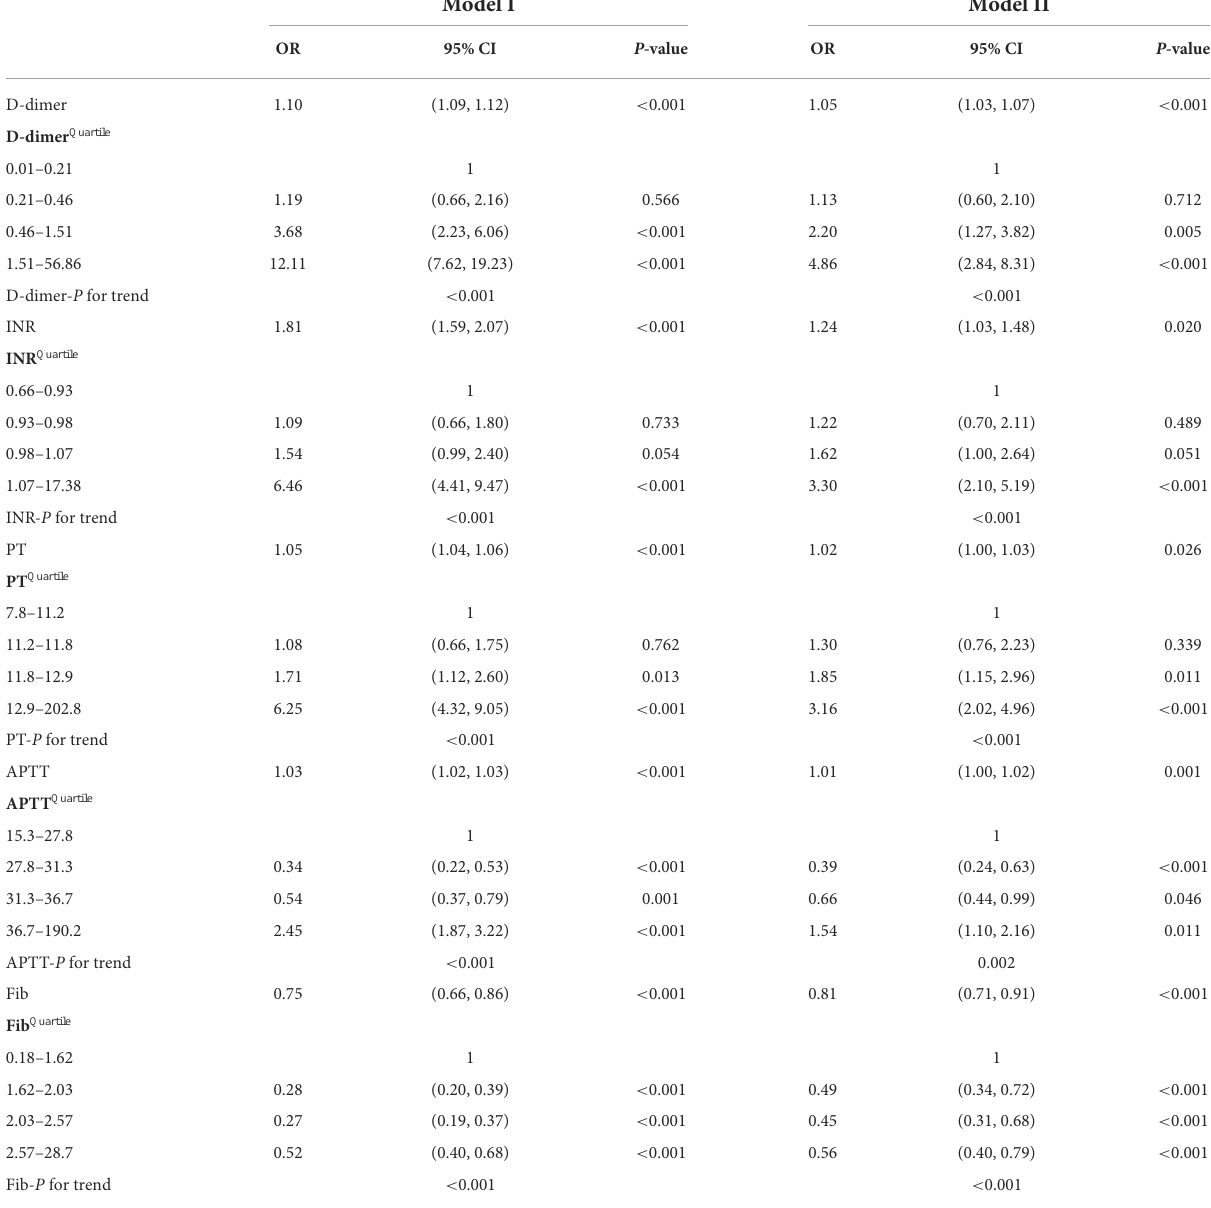
TABLE 2 Relationship between coagulation parameters and in-hospital mortality in different models of multivariable logistic